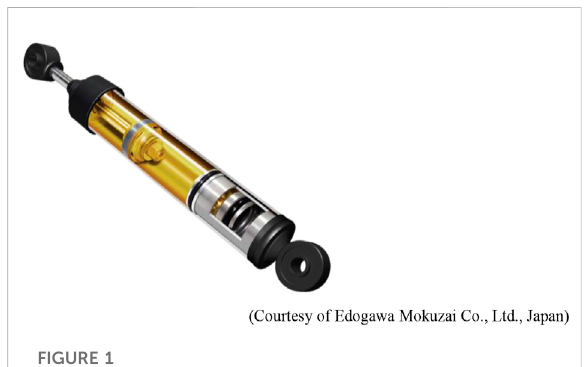
FIGURE 1 Small-size viscous damper for timber frame